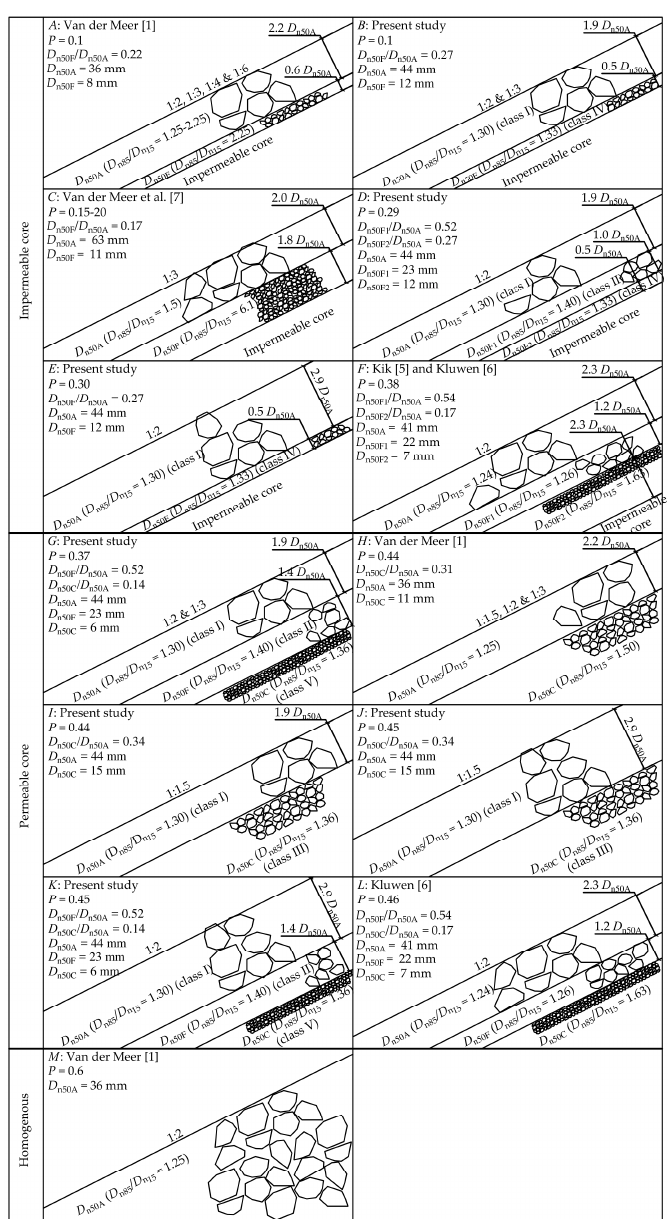
Figure 1. Fitted notional permeability factor of different layer compositions, for which A , H and M are given by Van der Meer [1], F is given by Kik [5] and Kluwen [6], L is given by Kluwen [6], C is given by Van der Meer et al. [7] and B , D , E , G , I , J and K are tested in the present study. D n50A is the nominal stone size of the armor, D n50F is the nominal stone size of the filter / underlayer material, and D n50C is the nominal stone size of the core